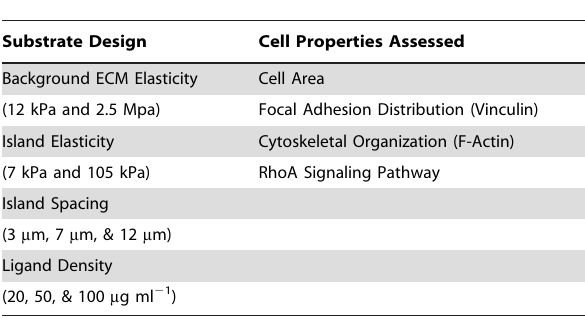
Table 1. Table showing the micropatterning characteristics including, background ECM elasticity, island elasticity, island topography, and ligand density